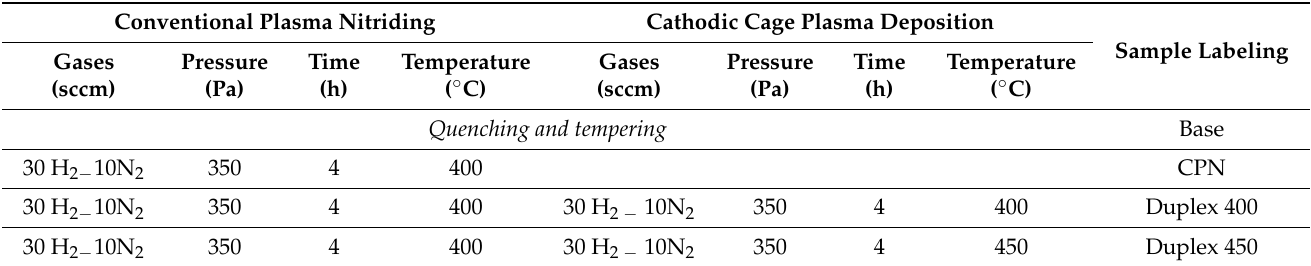
Table 2. Labelling of samples and corresponding treatment conditions. Conventional Plasma